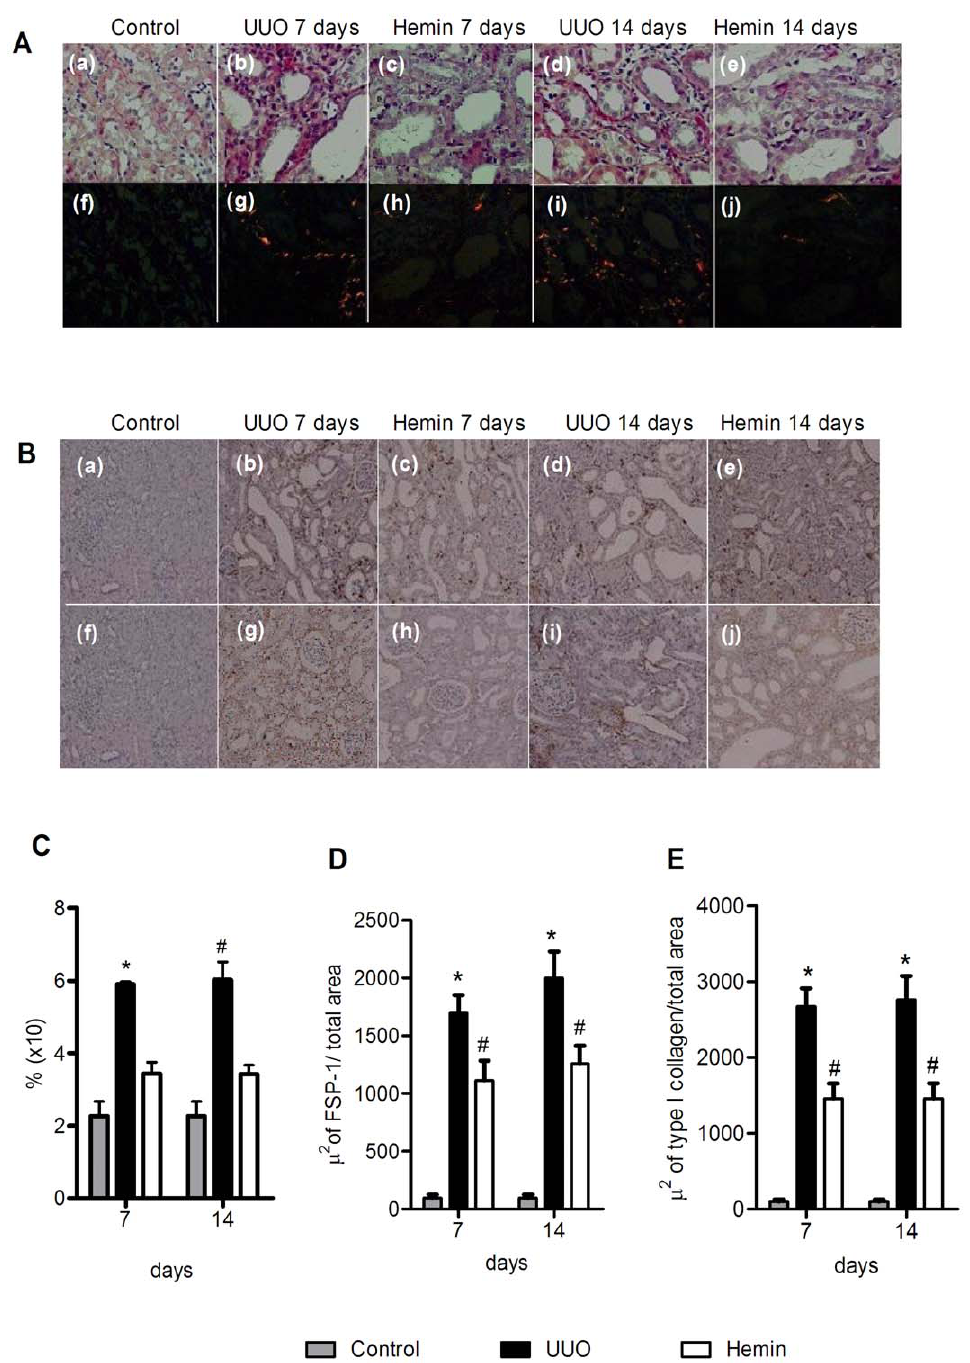
Figure 3. Upregulation of HO-1 promotes less fibrotic tissue deposition in the obstructed kidney. (A) Picrosirius staining from control kidneys and obstructed kidneys of UUO and Hemin-treated animals. Panels a, b, c, d, and e show the tissue when seen using a light microscope and the panels f, g, h, i, and j show the same tissue observed using polarized light. (B) Immunohistochemistry (IHC) for localization of FSP-1 (panels a, b, c, d, and e) and Collagen type I (panels f, g, h, i, and j) from control kidneys and obstructed kidneys of UUO and Hemin-treated animals. (C) Fibrosis area quantification from picrosirius staining (percentage of analyzed field) from groups represented in Figure 2A. The data is expressed as average 6 s.e.m. * p , 0,05 vs. Control and Hemin and # p , 0,001 vs. Control and Hemin. (D) A representative graph showing IHC quantification for FSP-1. *p , 0,001 vs Control and Hemin and # p , 0,05 vs Control. (E) Representative graph quantification for Collagen type 1 IHC. *p , 0,001 vs Control and Hemin and # p , 0,05 vs Control. doi:10.1371/journal.pone.0014298.g003 EDTA (pH 9) antigen retrieval solution at 95 u C. The endogenous (DAKO). Slides were incubated with a primary antibody or peroxidase activity was blocked with 3% hydrogen peroxide, and isotype non-specific IgG as negative control reagent, followed by sections were additionally blocked with Protein Block Solution incubation with the labeled polymer Envision (DAKO), using two